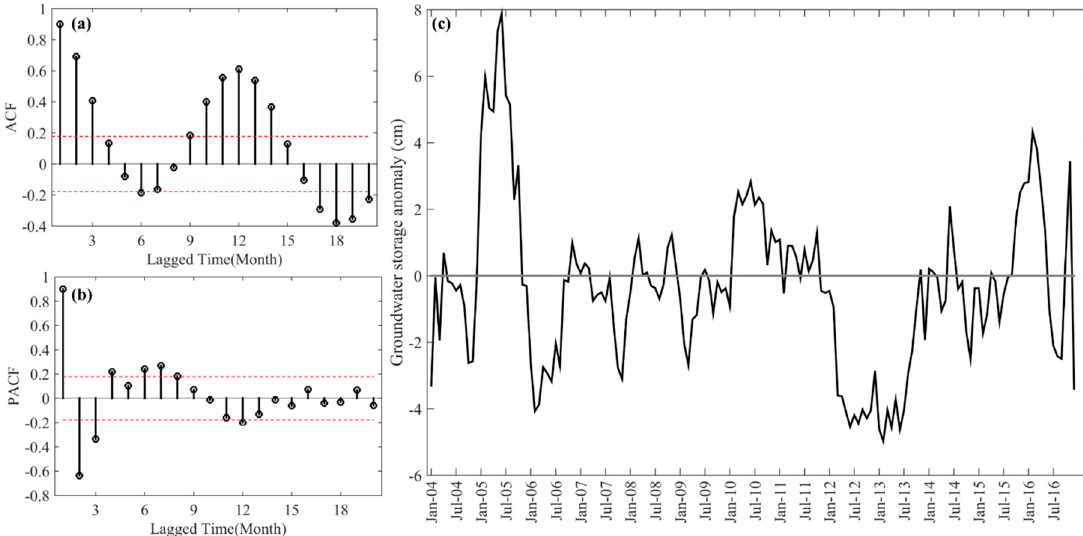
Figure 4. ( a ) Sample ACF ( b ) partial autocorrelation function (PACF) of Gravity Recovery and Climate Experiment (GRACE)-derived ∆ GWS (groundwater storage) data for an arbitrary grid and ( c ) Sample seasonally differenced GRACE-derived ∆ GWS data for the sample grid.